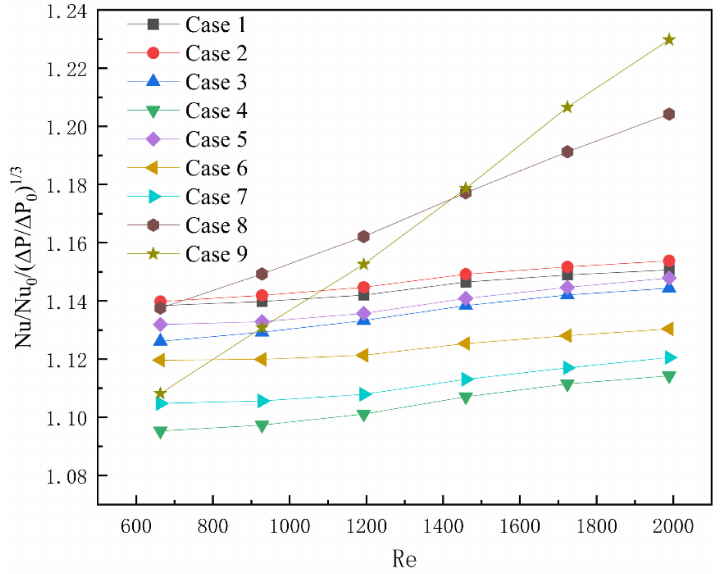
Figure 15. Comprehensive evaluation factors of different Cases at different Reynolds